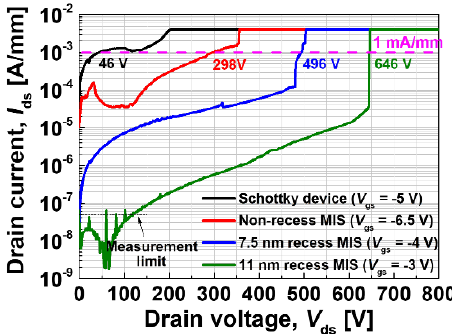
Figure 6. Off-state breakdown characteristics of the fabricated devices.